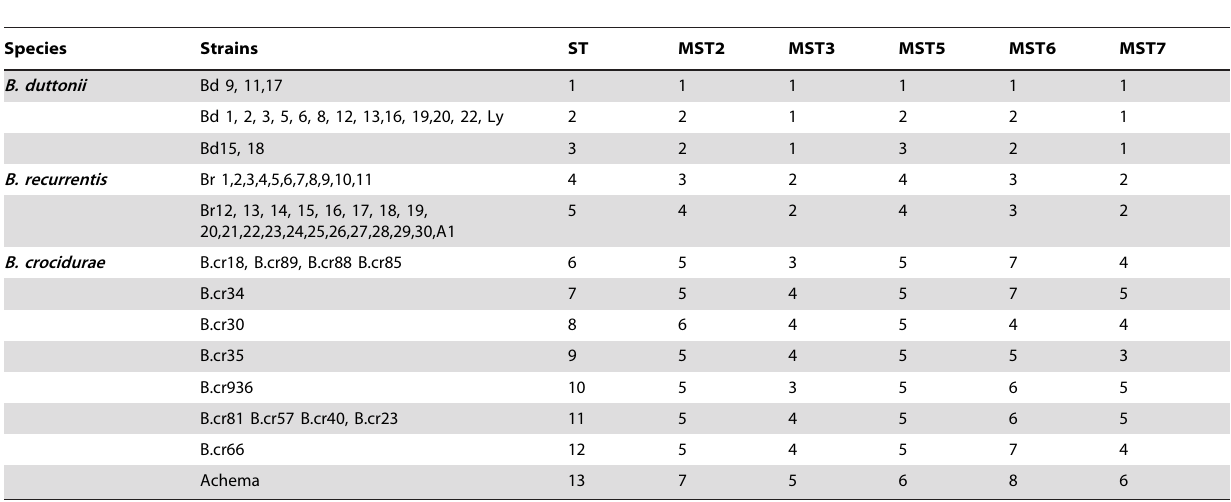
Table 3. List of spacer types (ST) found in this study.